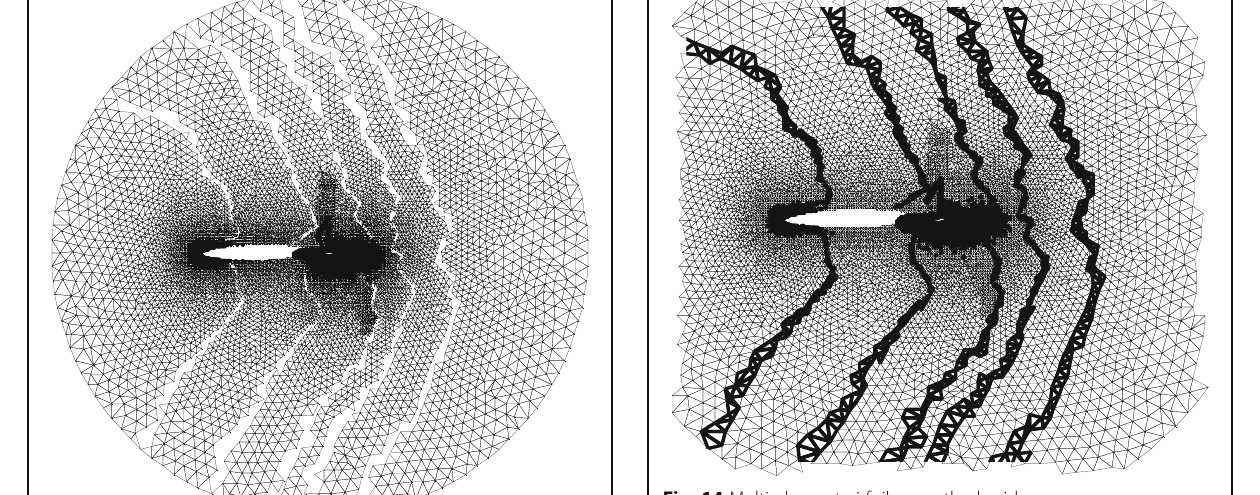
Fig. 14 Multi-element airfoil: smoothed grids